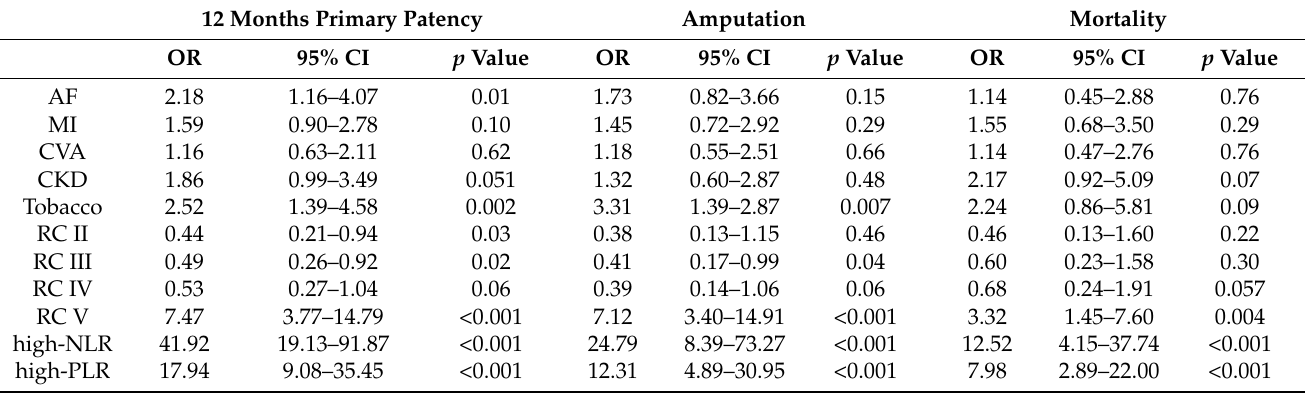
Table 6. Multivariate analysis on new adverse event occurrences during the entire study period.